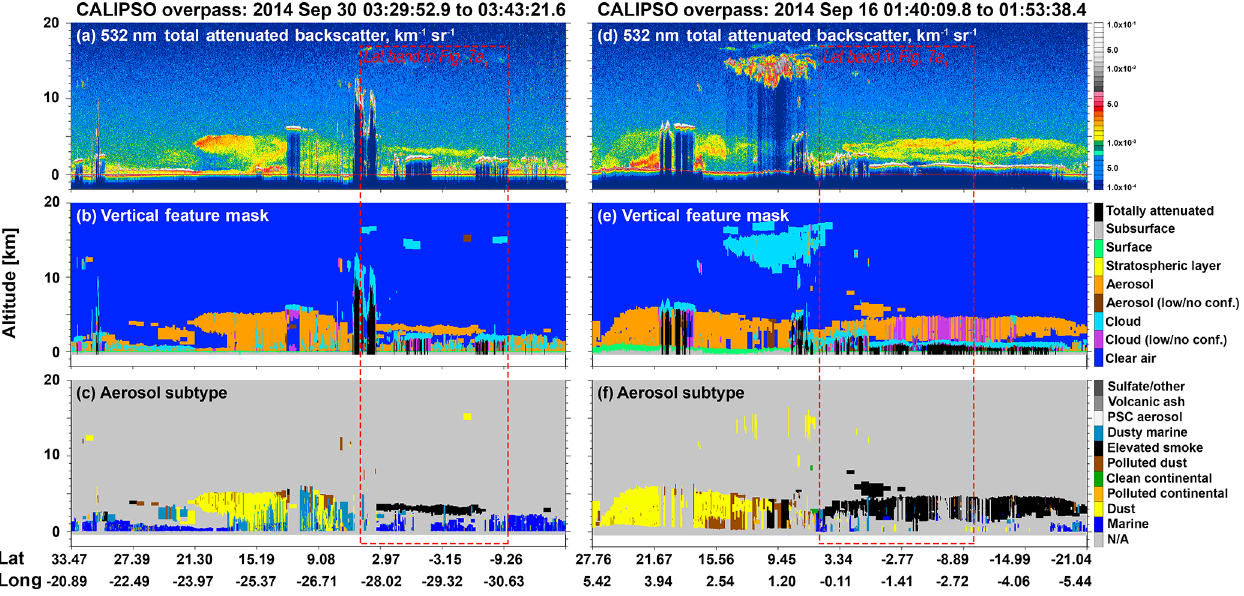
Figure 9. CALIPSO-derived lidar profiles for 16 and 30 September 2014, where African BB plumes were identified over the South Atlantic Ocean. The first profile near the South American coast shows the aerosol layer at similar altitudes to those observed during flight AC19. Satellite orbits for both profiles are shown in Fig. 7a 1